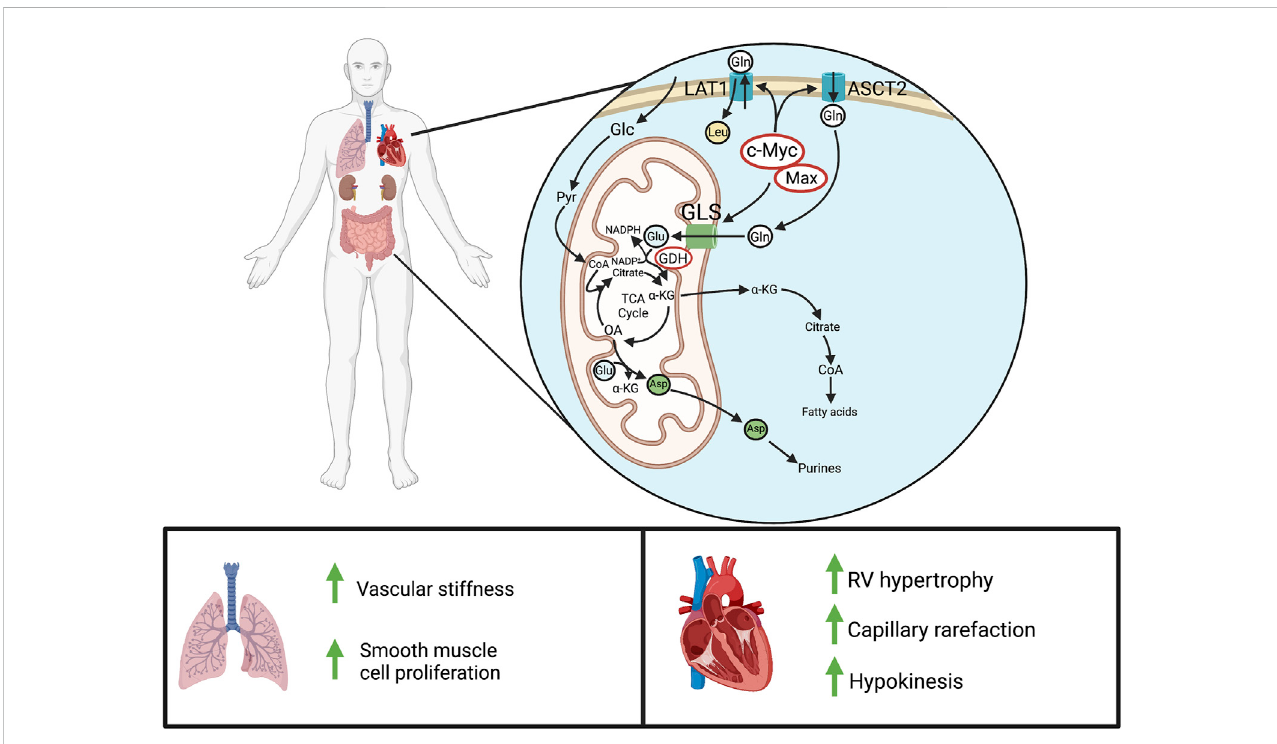
FIGURE 4 Glutaminolysis in PAH. Above: In normal adult cells, glutaminolysis predominantly occurs in actively proliferating cells, like those of the gastrointestinal tract and kidneys. In pathologic states of hyperproliferation, as occurs in cancer cells, there is also marked upregulation of glutaminolysis. Cellular glutamine entry is enhanced through c-Myc/Max-mediated transcription of the glutamine transporter, LAT1 (SLC7A5), and the ASCT2 (SLC1A5). GLS then produces glutamate for entry into the Krebs cycle, leading to α -ketoglutarate synthesis and downstream production of fatty acids, purines, and other metabolites. Below: In PAH, increased glutaminolysis in the pulmonary vasculature increases vascular stiffness and obstruction. In the normal RV, there is little or no basal glutaminolysis; however in PAH, cMyc and Max dramatically upregulate glutaminolysis. This contributes to RV hypertrophy and reduces RV